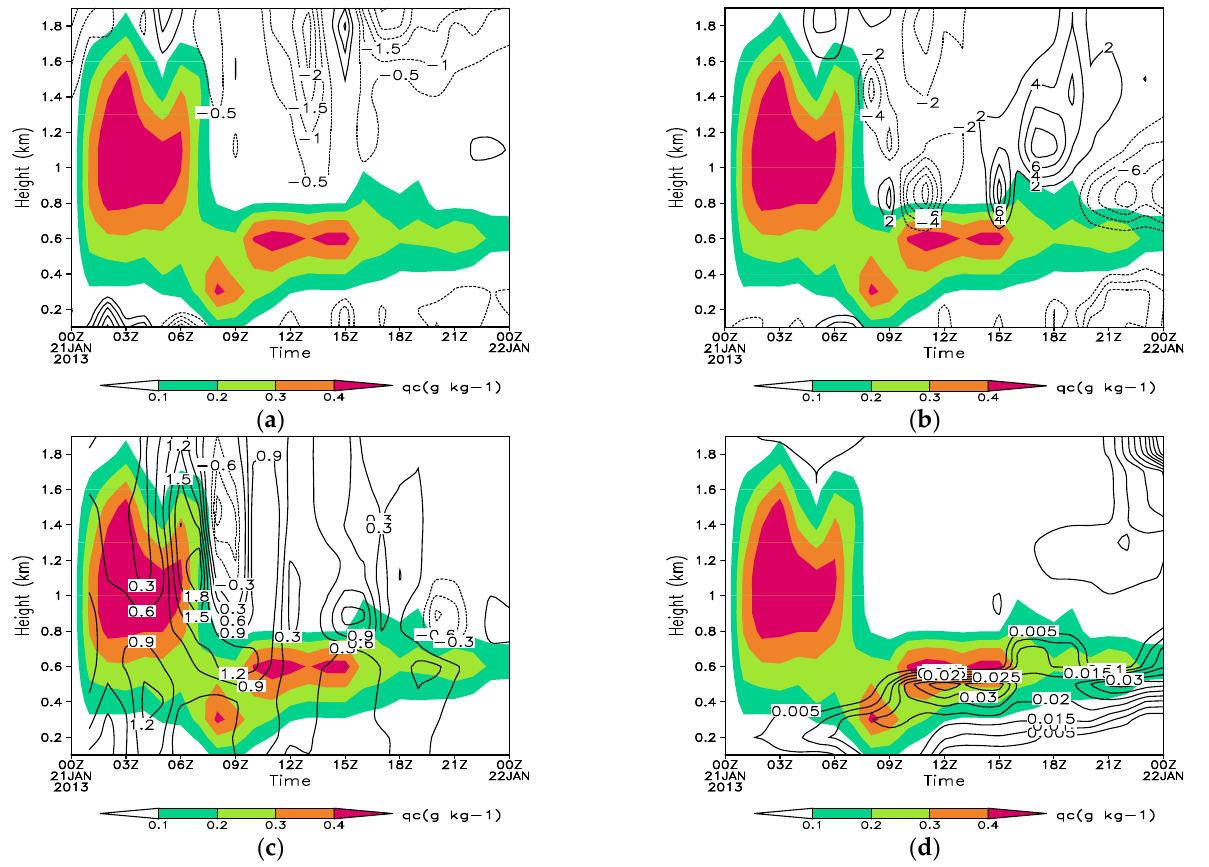
Figure 4. Regional average time series of contribution of three effects to relative humidity (contour, units: × 10 -5 s − 1 ) in central Yellow Sea: ( a ) advection effect in U-direction, ( b ) advection effect in V-direction, ( c ) radiation effect, and ( d ) turbulence effect (shading: cloud water mixing ratio, units: g kg − 1 ).